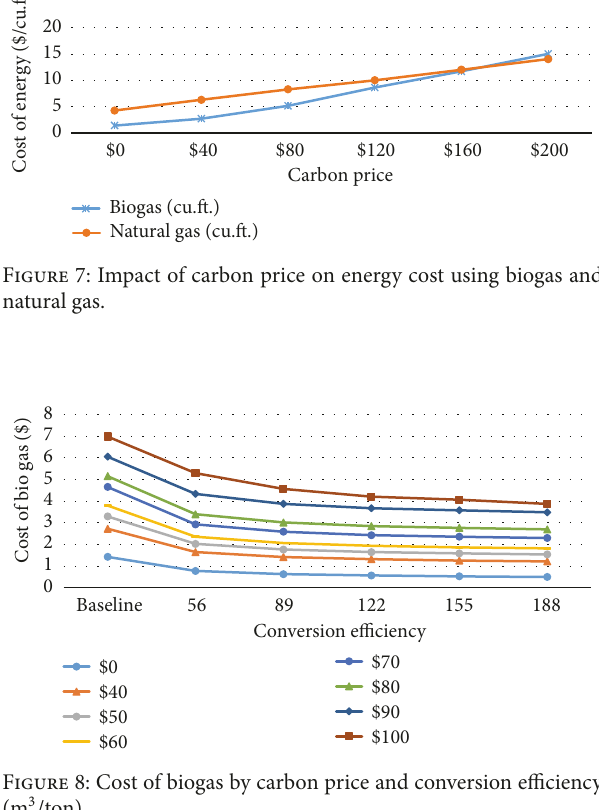
Figure 10: Impact of manure acquisition cost and carbon price on cost of